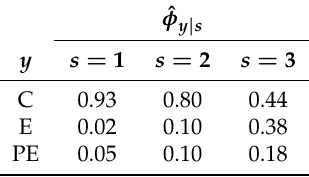
Table 3. Estimated conditional probabilities of responses given the latent state.